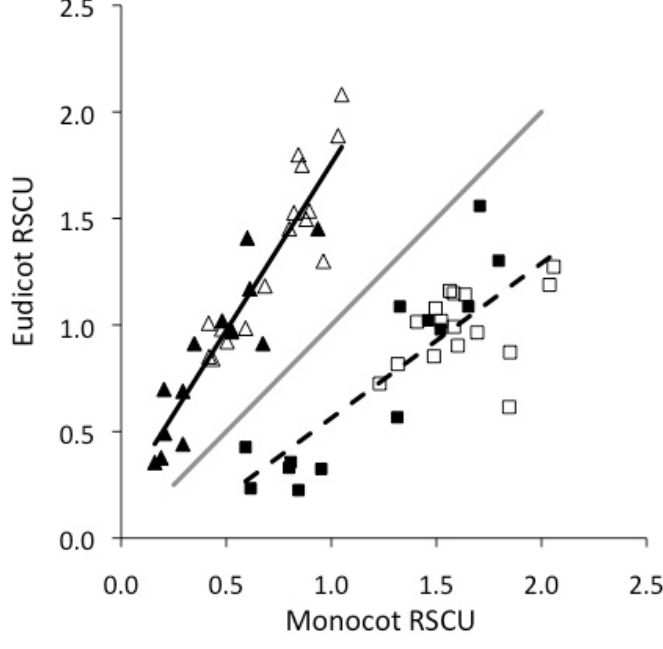
Figure 1. Relative synonymous codon usage (RSCU) correlation between monocot and eudicot highly expressed genes. Triangles represent A/T, squares are C/G, open symbols are pyrimidines, closed are purines. Solid line is best fit for A/T-ending codons (r=0.93), dashed is for G/C-ending (r=0.82). The grey line has a slope of 1 through the